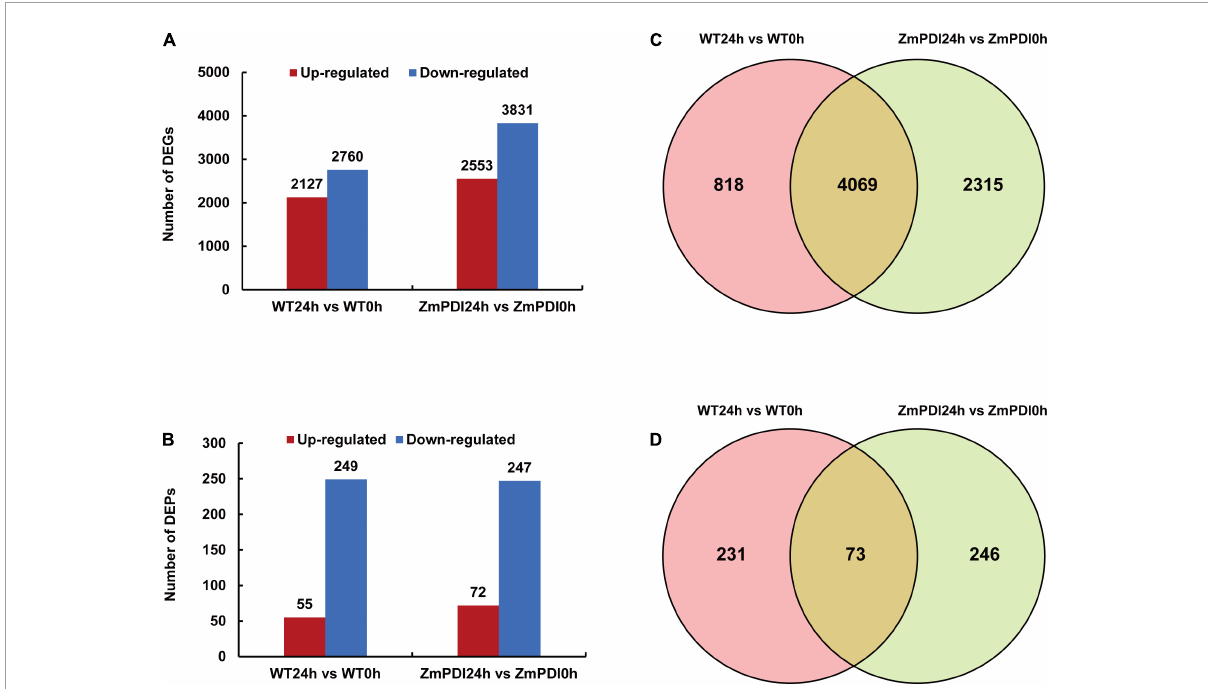
FIGURE2 Salt tolerance-related transcriptome and proteome expression profiles of OX-ZmPDI transgenic and WT plants of Z. matrella. (A) The number of up- and downregulated DEGs in OX-ZmPDI transgenic (ZmPDI24h vs. ZmPDI0h) and wild-type plants (WT24h vs. WT0h). (B) The number of up- and downregulated DEPs in OX-ZmPDI transgenic (ZmPDI24h vs. ZmPDI0h) and wild-type plants (WT24h vs. WT0h). (C) Venn diagram of the number of DEGs in the OX-ZmPDI transgenic and wild-type plants after salt treatment. (D) Venn diagram of the number of DEPs in the OX-ZmPDI transgenic and wild-type plants after salt